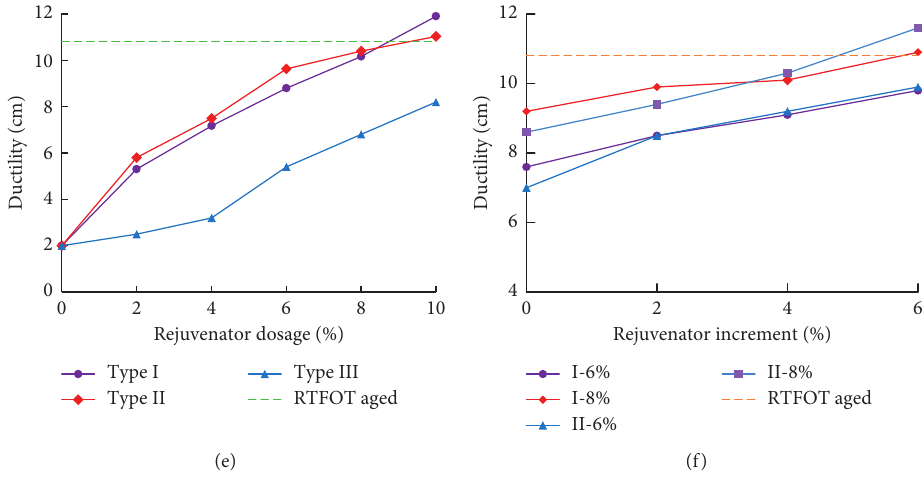
Figure 3: Physical properties of the first and second rejuvenated SBSMA. The first rejuvenation (a, c, e); the second rejuvenation (b, d,